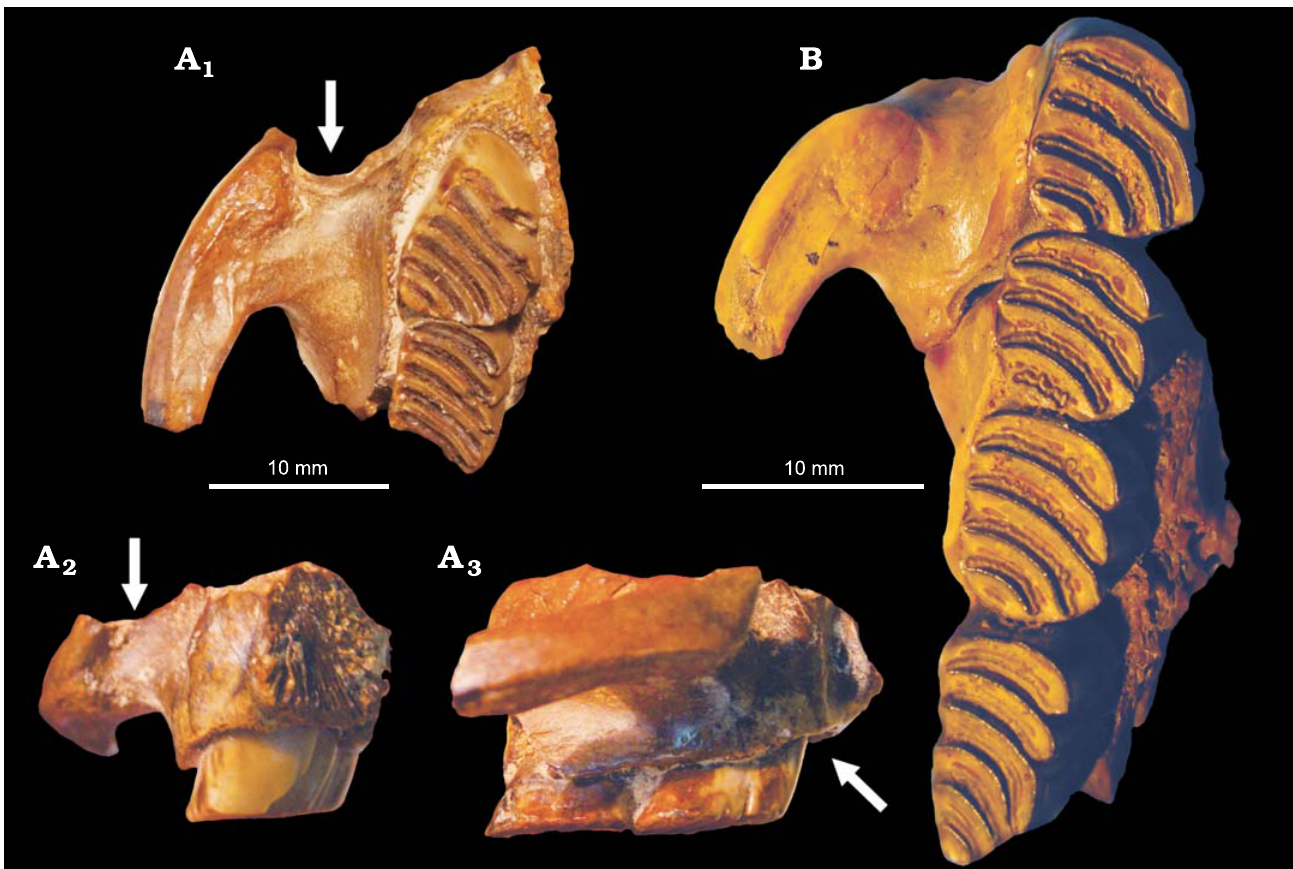
Fig. 7. Maxilla of potamarchine rodent Pseudopotamarchus villanuevai gen. et sp. nov. ( A , UFAC 4762) from Solimões Formation, Late Miocene, Brazil; in occlusal (A 1 ), anterior (A 2 ), and lateral (A 3 ) views, in comparison with Potamarchus murinus ( B , MACN-Pv 3500, inverted) from Ituzaingó Formation, Late Miocene, Argentina; showing the notch (arrows) on the anterior face of the ventral root of the zygomatic process of the